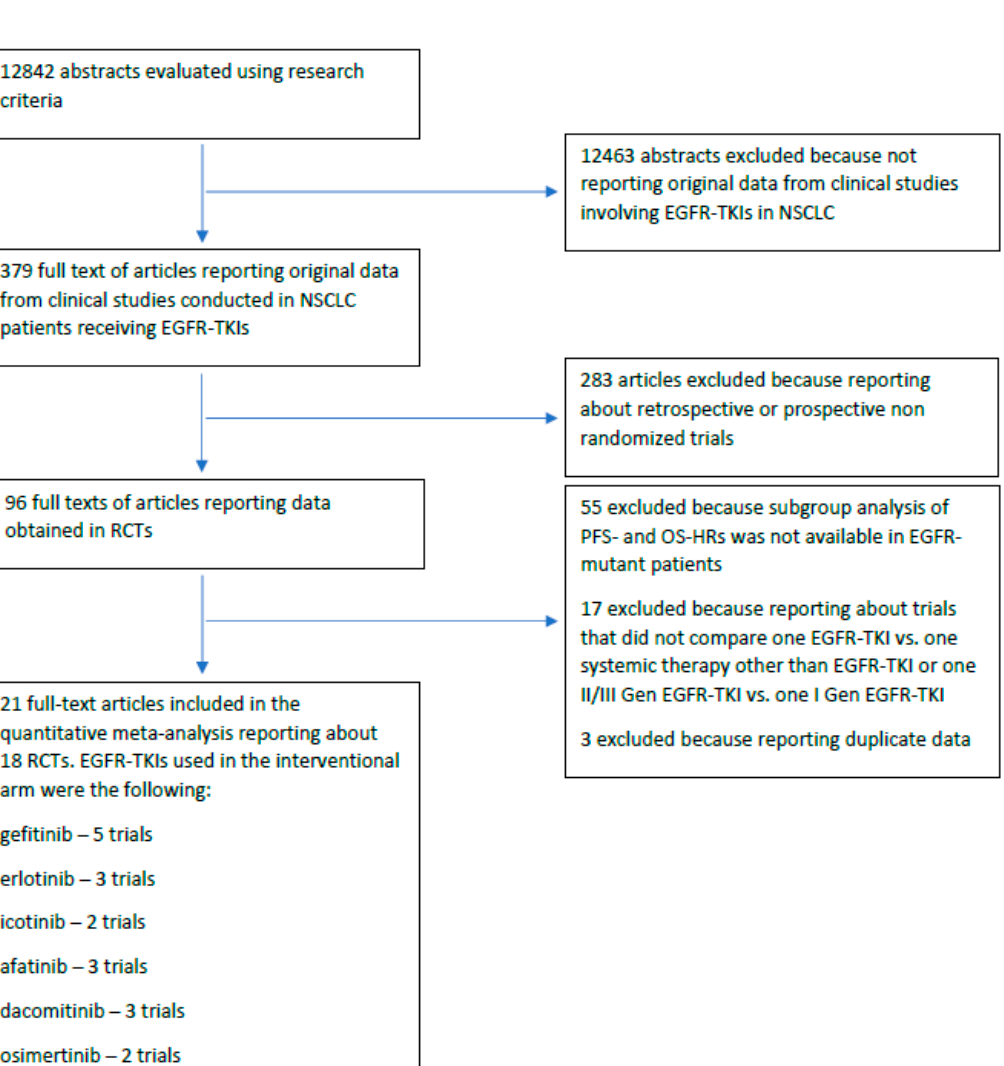
Figure 1. Flow-diagram of the systematic review. NSCLC = non-small cell lung cancer; Gen = generation; EGFR-TKIs = epidermal growth factor tyrosine kinase inhibitors; RCTs = randomized controlled trials; PFS = progression-free survival; OS = overall survival; HR = hazard ratio.